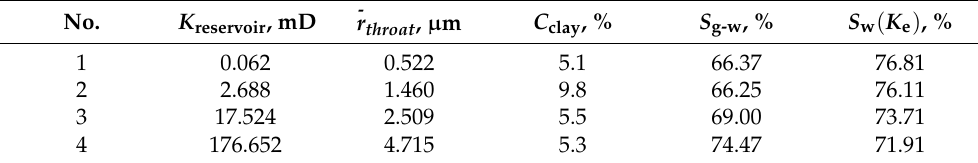
Figure 6. Relative and effective permeability curves of 4 cores. Table 5. Two-phase characteristic values and rock sample property parameters.